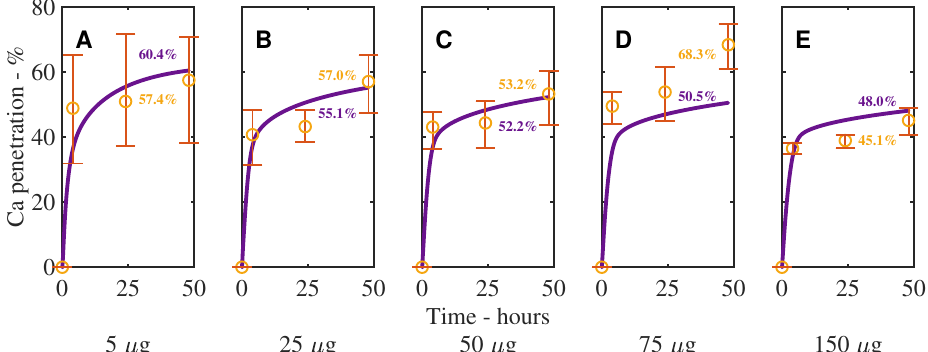
Figure 3. Numerical solution (purple line) of the model compared to experimental data (orange circles) for CaCl with RSO 5, using an initial applied mass of Ca of 5 µ g ( A ), 25 µ g ( B ), 50 µ g ( C ), 75 µ g ( D ), 2 150 µ g ( E ) with RSO 5 (1 g/L) over 48 h. Percentage Ca penetration is compared to time in hours, calculated according to Equation (25). The numerical solution can be seen as the continuous purple line and the experimental data as orange circles with error bars. The final percent Ca penetration is shown on each subfigure at 48 h.